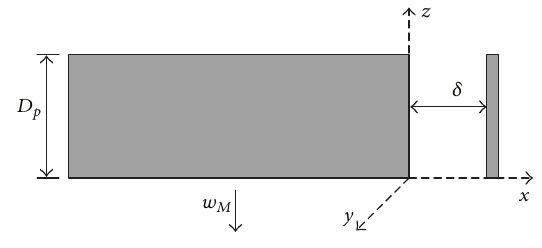
Figure 2: Flow between parallel